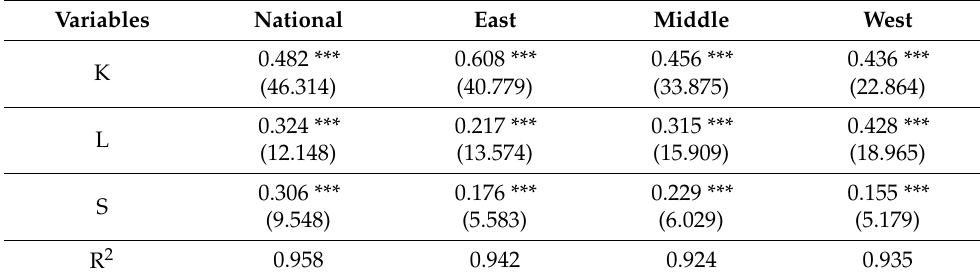
Table 3. Table of element output elasticity